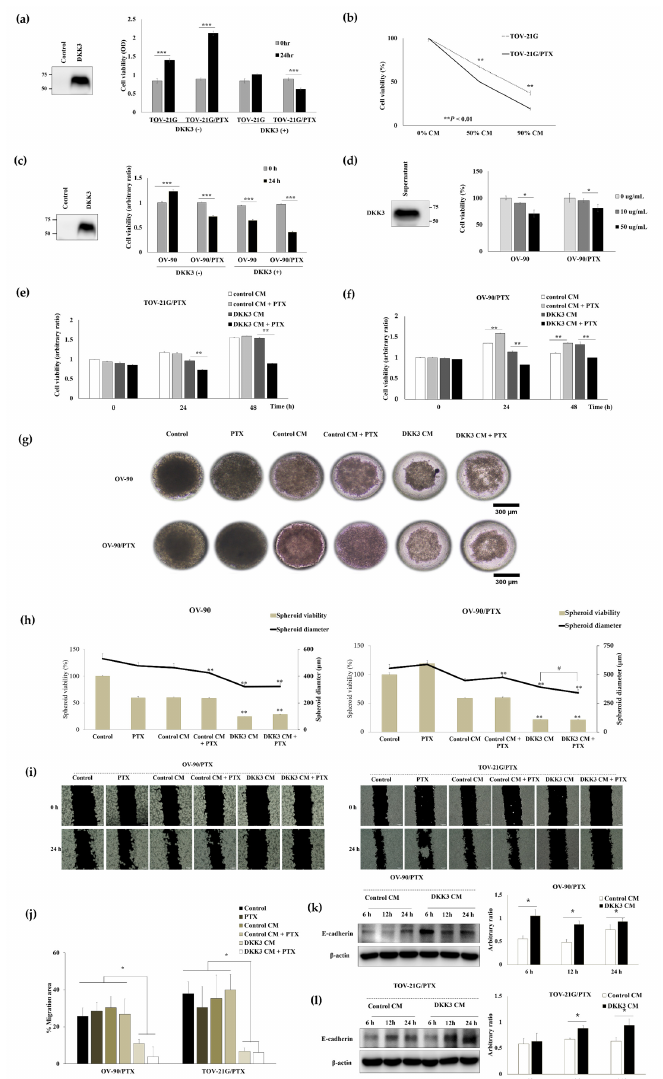
Figure 3. Anti-proliferative effect of the secreted DKK3 on paclitaxel-resistant cells. ( a ) Western blotting results show DKK3 protein levels in the control and DKK3 conditioned medium (CM). MTT assay performed after 24 h of incubation with CM (*** p < 0.001). ( b ) The viability of TOV-21G and TOV-21G/PTX cells after treatment with DKK3 CM diluted to 0%, 50%, and 90%, respectively, with control CM (** p < 0.01). ( c ) The OV-90 and OV-90/PTX cells were incubated with CM with or without DKK3. Western blotting results show DKK3 protein levels in the control and DKK3 CM. MTT assay after 24 h of treatment (*** p < 0.001). ( d ) Western blotting reveals recombinant human DKK3 levels. Two concentrations of the protein (10 µ g/mL and 50 µ g/mL) were used to treat cells for 72 h (* p < 0.05). ( e , f ) TOV-21G/PTX and OV-90/PTX cells were treated with CM with or without paclitaxel (100 ng/mL and 200 ng/mL, respectively) (** p < 0.01). ( g ) 3D spheroids of OV-90 and OV-90/PTX cells were generated in a microwell array and the images were captured after incubation for 6 d (magnification, 40 × ; scale bar 300 µ m). ( h ) Spheroid viabilities and diameters were compared. The asterisks on the graph denote statistically significant differences ( p < 0.01) between the DKK3 CM group and the control CM group. The diameter of spheroids in the DKK3 CM group was compared to that in the DKK3 CM with paclitaxel group (#, p < 0.01). ( i , j ) OV-90/PTX and TOV-21G/PTX cells were treated as mentioned above and migration rates were evaluated using the migration assay. ( k , l ) The paclitaxel-resistant cells were incubated with control and DKK3 CMs. At the indicated time points, the cells were harvested and subjected to Western blotting. The graphs were plotted based on the band densities measured using the ImageJ software. * p <